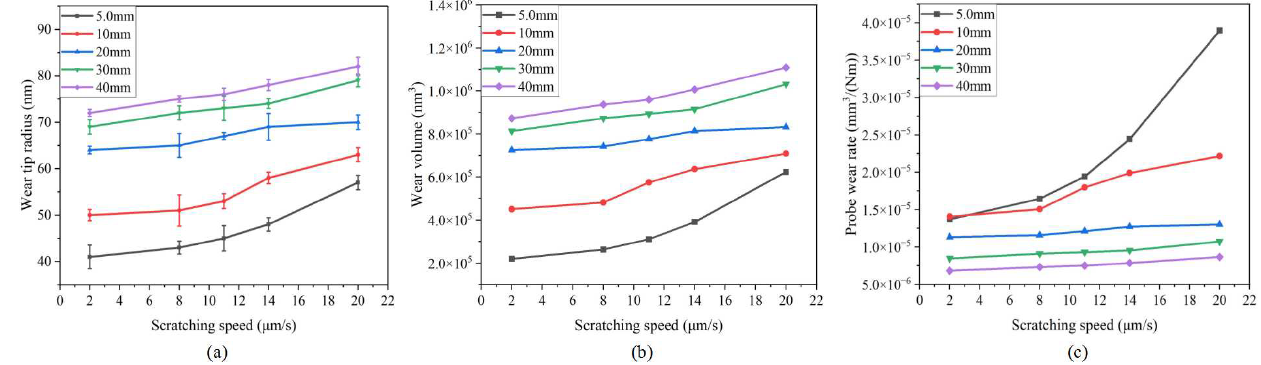
Figure 10. Relationship between scratching speed and evaluation index of probe wear state: ( a ) wear tip radius; ( b ) wear volume; ( c ) probe wear rate .